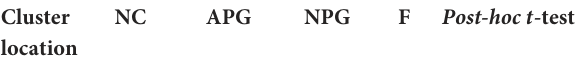
TABLE 3 Post hoc pairwise comparisons of the mean VMHC z-score in three groups ( * p < 0.05).